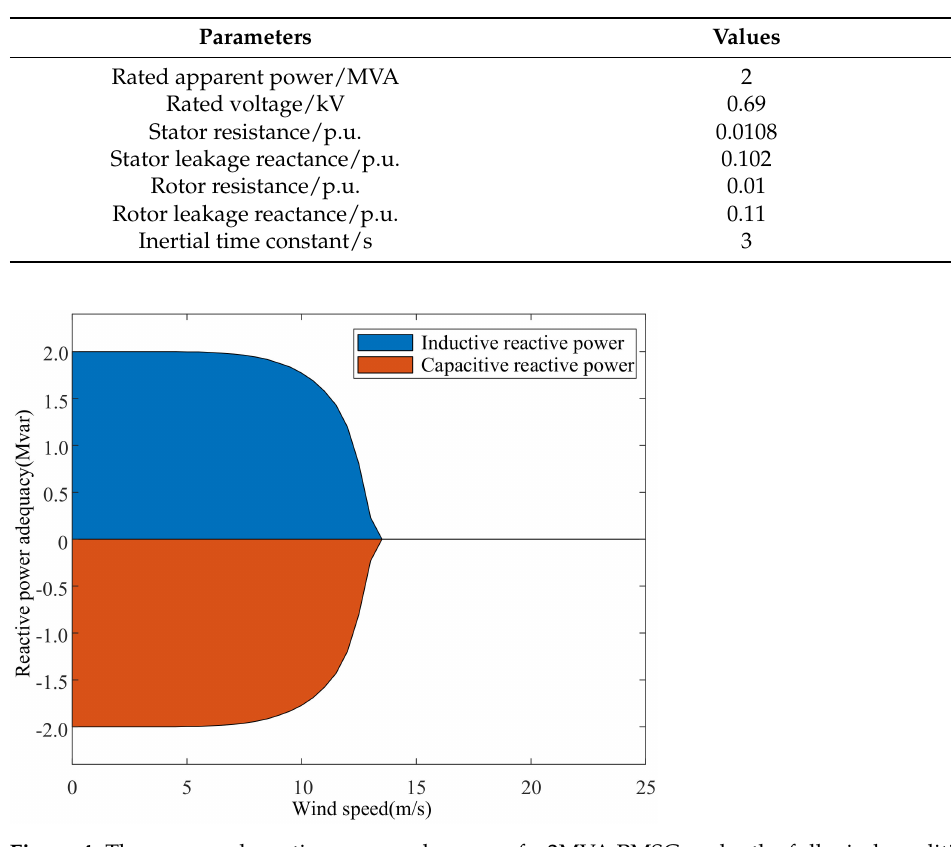
Table 2. The related parameters of a 2MVA PMSG.